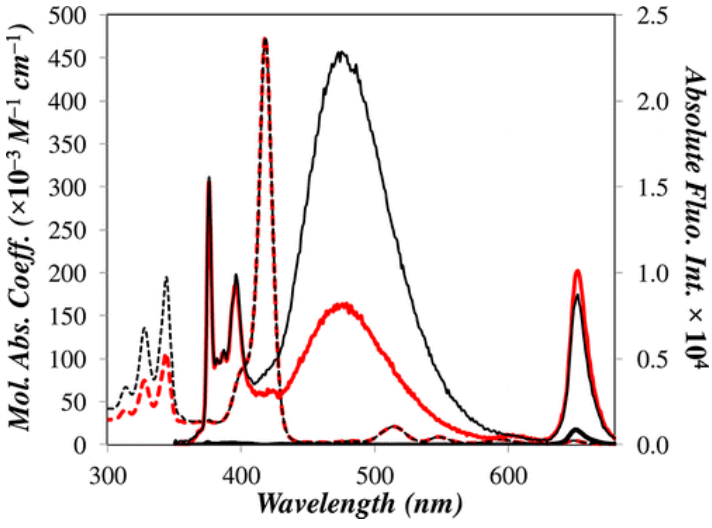
Figure 3. Absorption (dashed line) and fluorescence (solid line) spectra of Py 2 -TMEG1 (red line), Py 4 -TMEG2 (thin black line), and fluorescence spectrum of TME (porphyrin precursor without pyrene units) (thick black line with a low fluorescence intensity at 651 nm) in THF. [Py 2 -TMEG1] = 5.1 × 10 –7 M; [Py 4 -TMEG2] = 2.6 × 10 –7 M; and [TME] = 2.5 × 10 –6 M; λ ex = 344 nm. Reprinted with